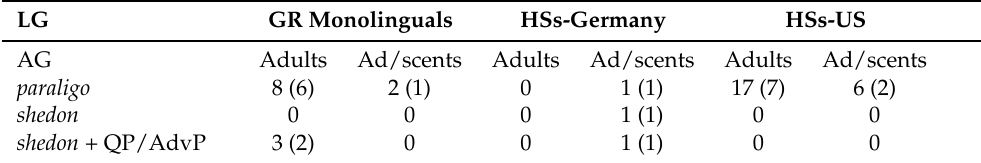
Table 2. Distribution of paraligo and shedon constructions across groups and age